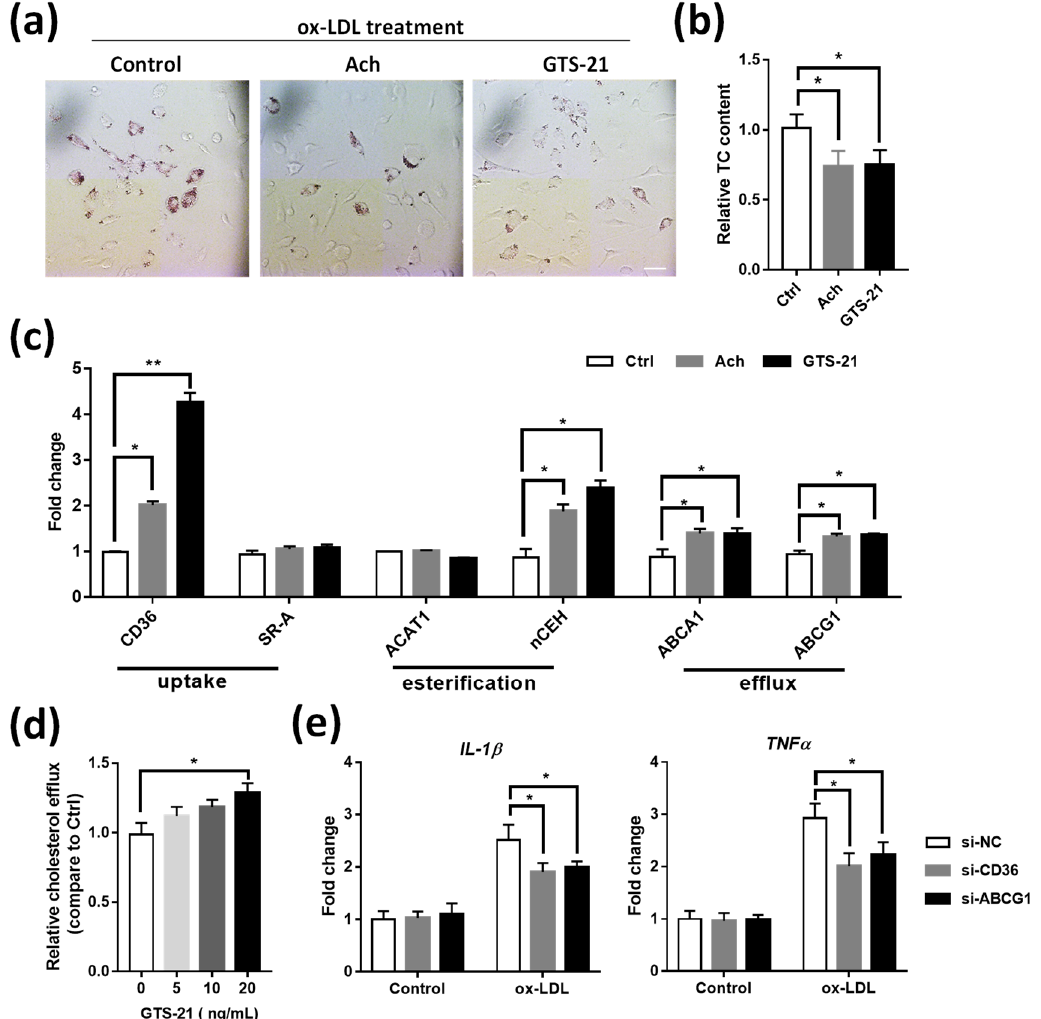
Figure 6. Effects of CAP agonists on ox-LDL induced macrophage foam cell formation. ( a ) Thioglycollate-elicited macrophages were treated with CAP agonist in the presence of ox-LDL to induce foam cell formation. The cells were then stained with ORO. Scale bar represents 50 μ m. ( b ) Relative quantification analysis of total cholesterol in cultured peritoneal macrophages of ( a ). Data are presented as means ± SD ( n = 3 biological replicates). ( c ) The mRNA expression analysis of genes associated with cholesterol metabolism in peritoneal macrophages treated with CAP agonist in the presence of ox-LDL. Data are presented as means ± SD ( n = 3 biological replicates). * p < 0.05, ** p < 0.01 as compared to blank cells. ( d ) Relative cholesterol efflux mediated by different concentrations of GTS-21 treatment in peritoneal macrophages loaded with NBD-